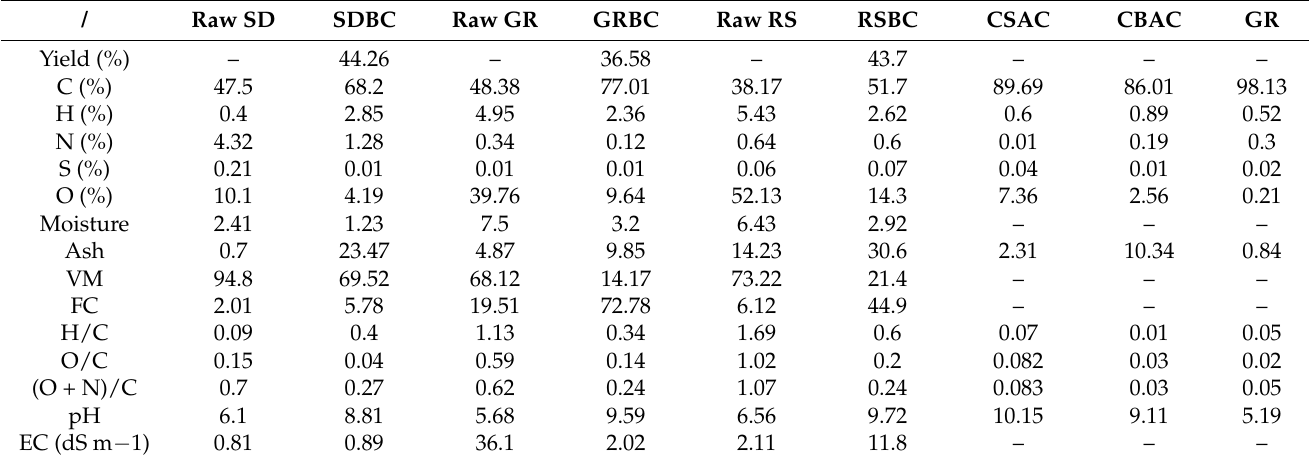
Table 1. Bulk elemental composition, ash content, atomic ratio, pH, and EC for raw biomasses and